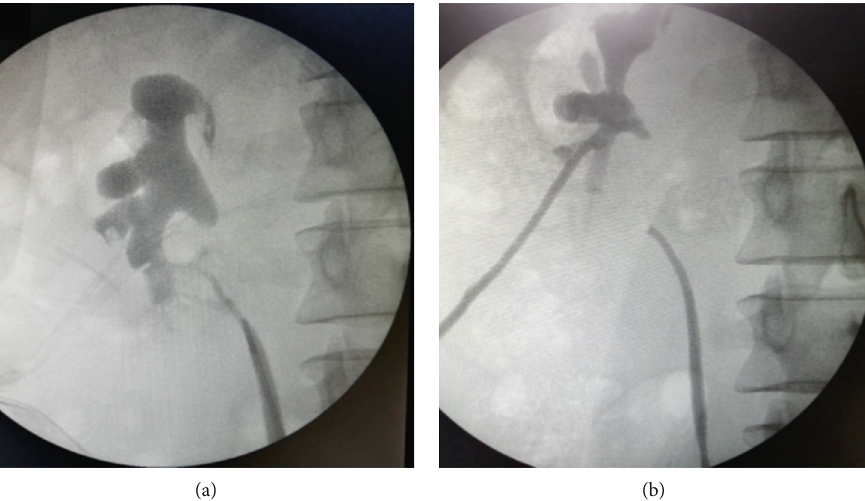
Figure 2: (a) Retrograde pyelography showing a fi stulous tract between the upper ureter and the inferior calyceal system. The blind end of the renal pelvis is also seen. (b) Simultaneous retrograde and antegrade pyelography following the insertion of the nephrostomy